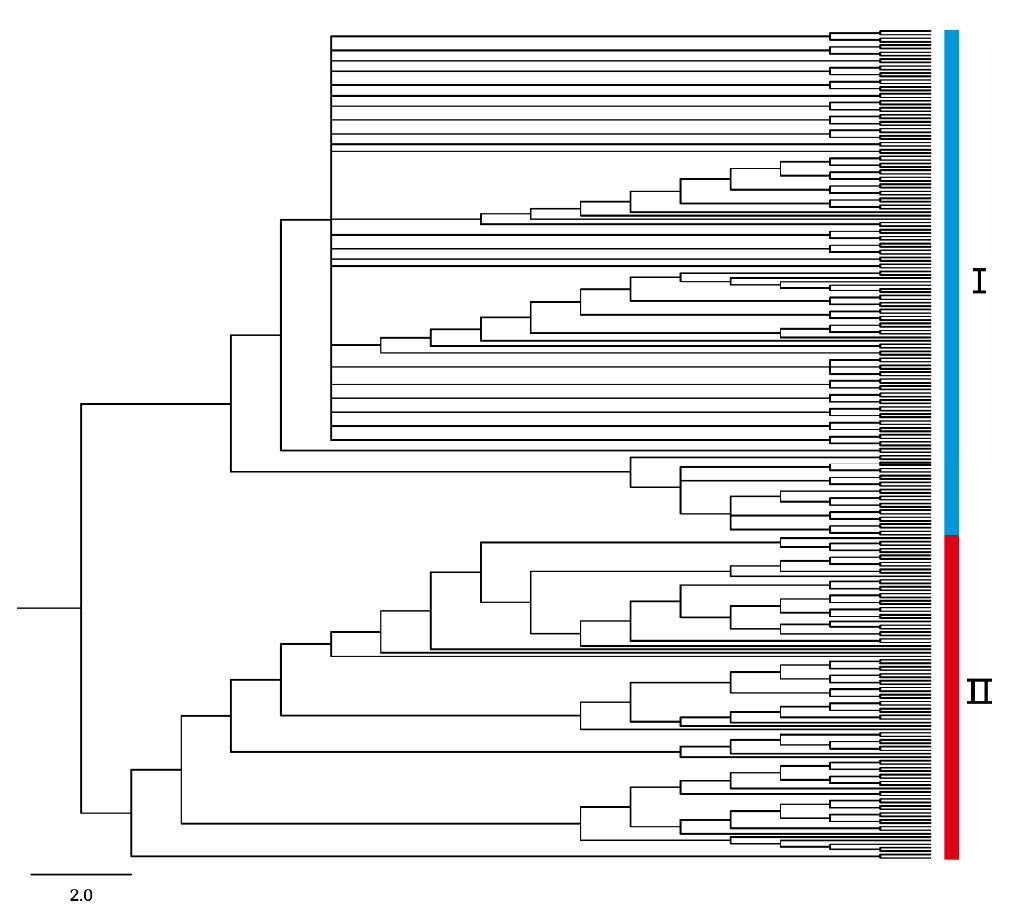
Figure 4. The topology structure of Bayesian phylogeny for the MLST SNPs. Note: all genotypes belonging to lineages I and II are indicated in the phylogenetic tree, the bars’ colors correspond to the genetic clusters indicated by STRUCTURE, and the strain numbers of each clade are listed in Table S5.